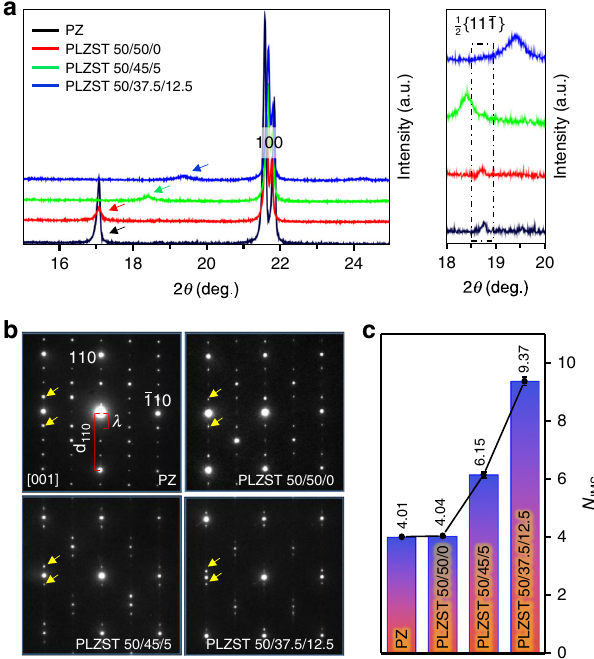
Fig. 1 Average structural characteristics of PbZrO 3 and PLZST system. a The XRD patterns showing two types of superlattice re fl ections originated from the cations modulation marked by arrows and octahedra tilts marked by dash rectangle, respectively. The 2 θ range of 18° – 20° are enlarged on the right to clearly show 1/2{11 (cid:1) 1} peaks associated with antiphase tilt of oxygen octahedra. The main {100} peaks of PbZrO 3 is approximately aligned with PLZST 50/50/0 for clearly comparing modulation period. b The [001] SAED patterns showing the modulation wave along [110] direction. The satellite re fl ections associated with modulation mode are marked by yellow arrows. c The modulation period ( N IMS ) = λ /d 110 ( λ refers to modulation wavelength in real-space) calculated from SAED patterns. The average data of modulation period for each sample is obtained from more than fi ve different areas and error bars represent the standard